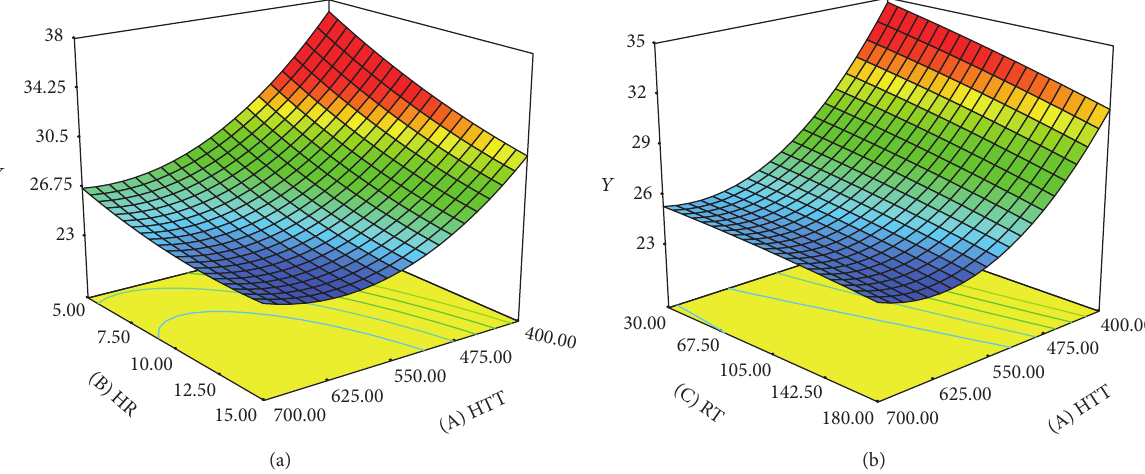
Figure 3: (a) Surface plot of percentage of yield ( 𝑌 ) as a function of highest treatment temperature (HTT) and heating rate (HR) at fixed residence time of 105 minutes. (b) Surface plot of percentage of yield ( 𝑌 ) as a function of highest treatment temperature (HTT) and residence time (RT) at fixed heating rate of 10 ∘ C per minute.